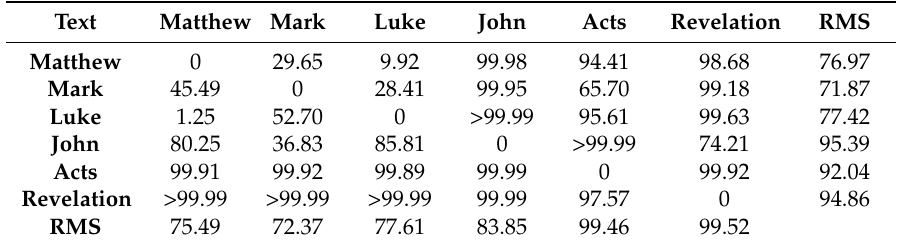
Table 8. Full Texts. Kolmogorov–Smirnov test results for P F (below the diagonal of zeros) and C P (above the diagonal). The values reported are the confidence level (%) that the indicated couple of probability distributions are not identical. For example, the confidence level that the number of words per sentence, P F , in Mark and Luke are not identical is 1.25%, therefore the two probability distributions are, in effect, indistinguishable. The confidence level that the number of characters per word, C P , in Mark and Luke are not identical is 29.25%, therefore the two probability distributions are not very different, thus indicating that the words contained in their dictionary are of about the same length. The root mean square (RMS) value is calculated as follows. Example, Luke’s P F